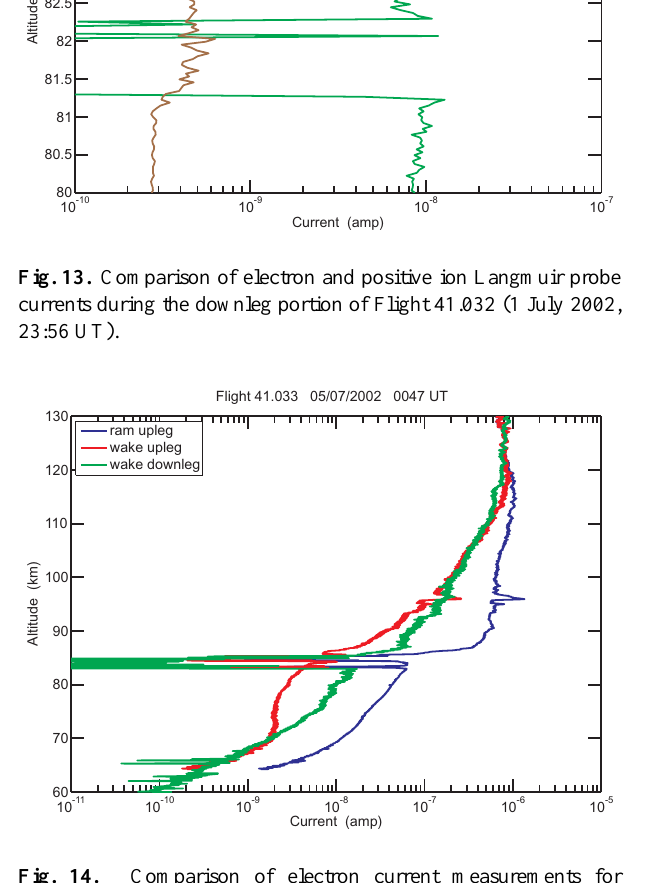
Fig. 14. Comparison of electron current measurements for Flight 41.033 (5 July 2002, 00:47